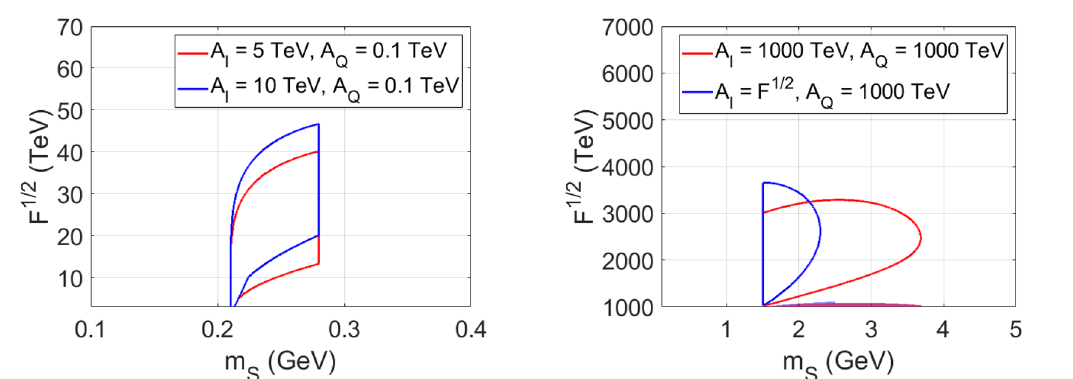
Figure 16 . The sensitivity regions of FASER-I to sgoldstino, produced in η − meson decays with A Q = 100 GeV (left panel) and FASER-II to sgoldstino, produced in beauty meson decays (right panel) due to flavor-conserving couplings, and decaying to a couple of muons inside the detector. M 3 = 3 TeV, M γγ = 100 GeV. Shaded areas correspond to restrictions from table 1. In the regions √ √ where F < A l we set A l = F